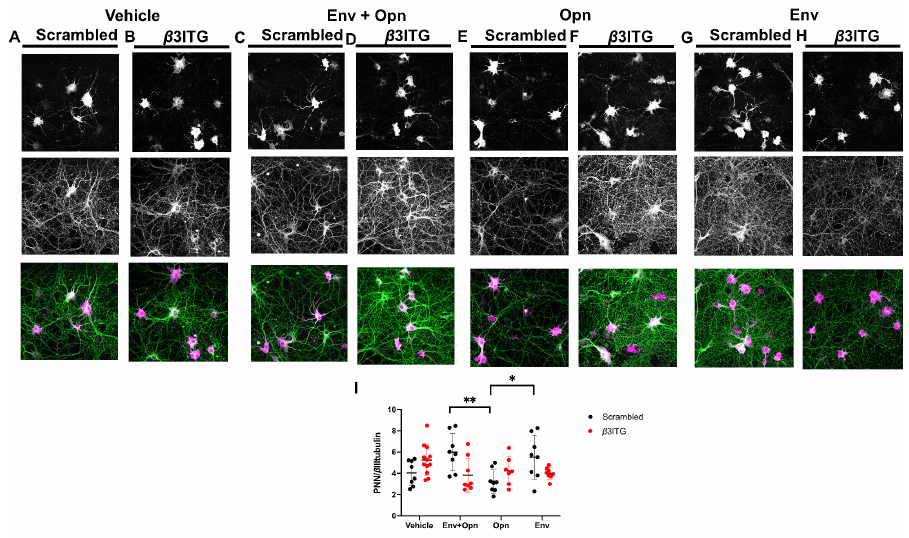
Figure 5. β 3 integrins do not modulate PNN expression in the presence of HIV-1 Env and Opn. Figure 1. Opn counteracts HIV-1 Env mediated post-synaptic damage. Representative images of Representative images of hippocampal neurons stained with PNN glycoprotein marker (WFA) and primary hippocampal neurons treated with vehicle ( A ), Env only ( B ), Opn only ( C ), and Env + Opn ( D ) neurite marker β III-tubulin are shown. Top panel shows PNN stain, middle shows β III-tubulin, are shown. Left panel shows image of the entire neuron and on its top-right is a section of the dendrite and bottom panel shows the merged image. Exogenous treatments include the following: and 3D construction of the dendrite section below it. ( E ) shows grouped interleaved scatter graph for the number of synapses per neuron due to the four di ff erent treatments. The mean deviation (SD) are shown with the following number of sampling for each groups: n = 4 and 45 neurons for vehicle treated neurons, n = 3 and 34 neurons for Env only, n = 3 and 13 neurons for Opn only and n = 4 and 52 neurons for Env + Opn. Two-way ANOVA with Tukey’s post-test was performed to reveal statistical di ff erence between groups (** p < 0.001).